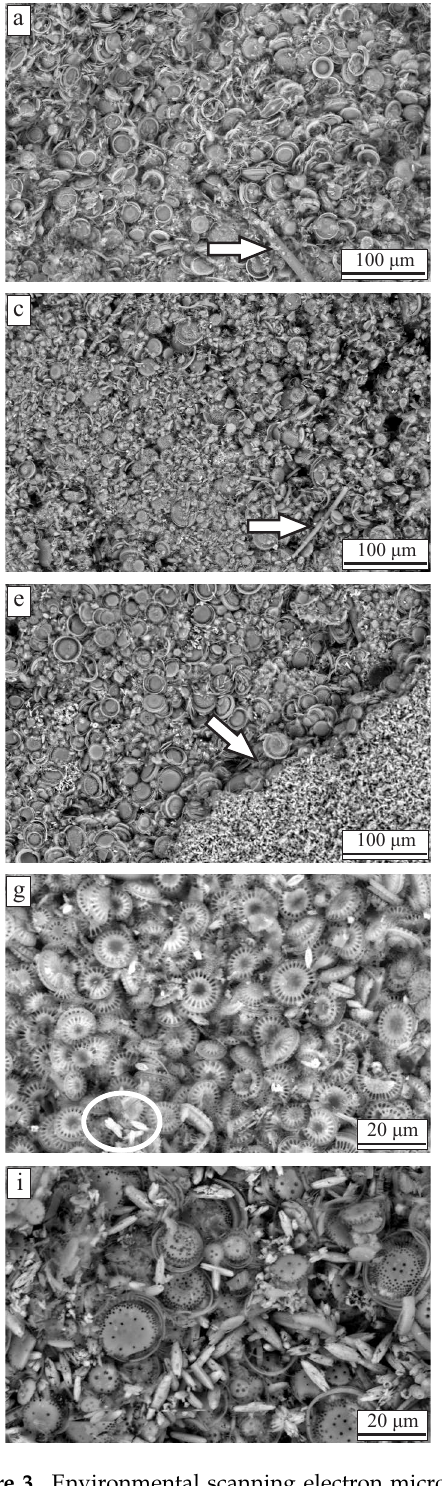
Figure 3. Environmental scanning electron microscopy (ESEM) microphotographs of the diatomite ore: ( a ) QG1 with fragments of sponge spicules; ( b ) QG1 with the occurrence of the genus Navicula ; ( c ) QG2 with fragments of sponge spicule; ( d ) QG2 with carbonate cement; ( e ) QG3 with sharp contact between silica and carbonate laminae; ( f ) QG3; ( g – i ) QG4 with rod-likearagonite crystals; ( j ) carbonate lamina composed mainly of rod-like aragonite crystals (zoom in from microphotograph ( e